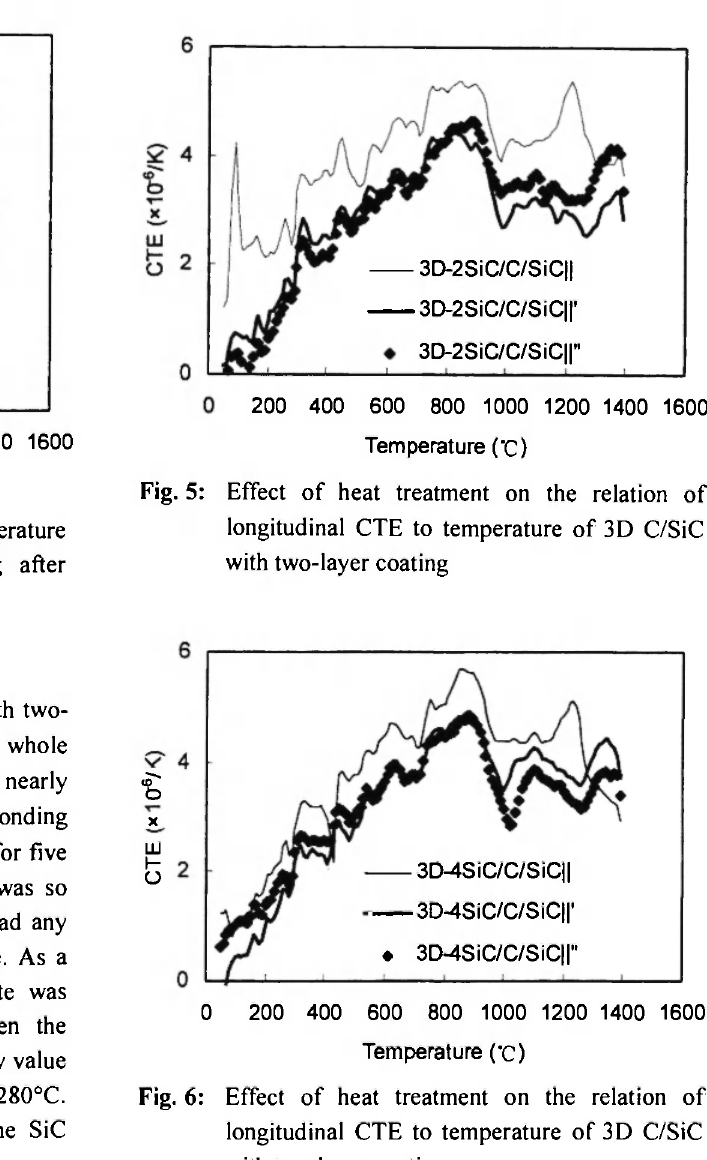
Fig. 6: Effect of heat treatment on the relation of longitudinal CTE to temperature of 3D C/SiC with two layer